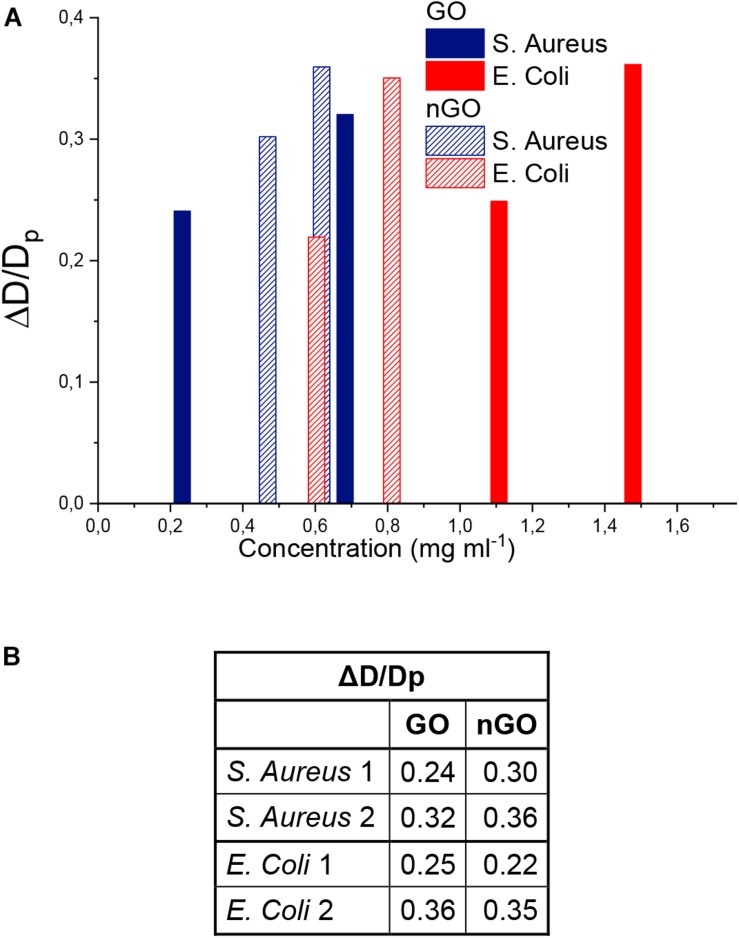
ΔD/DP ratio. (A) All systems. (B) Box ΔD/DP summarized dates.